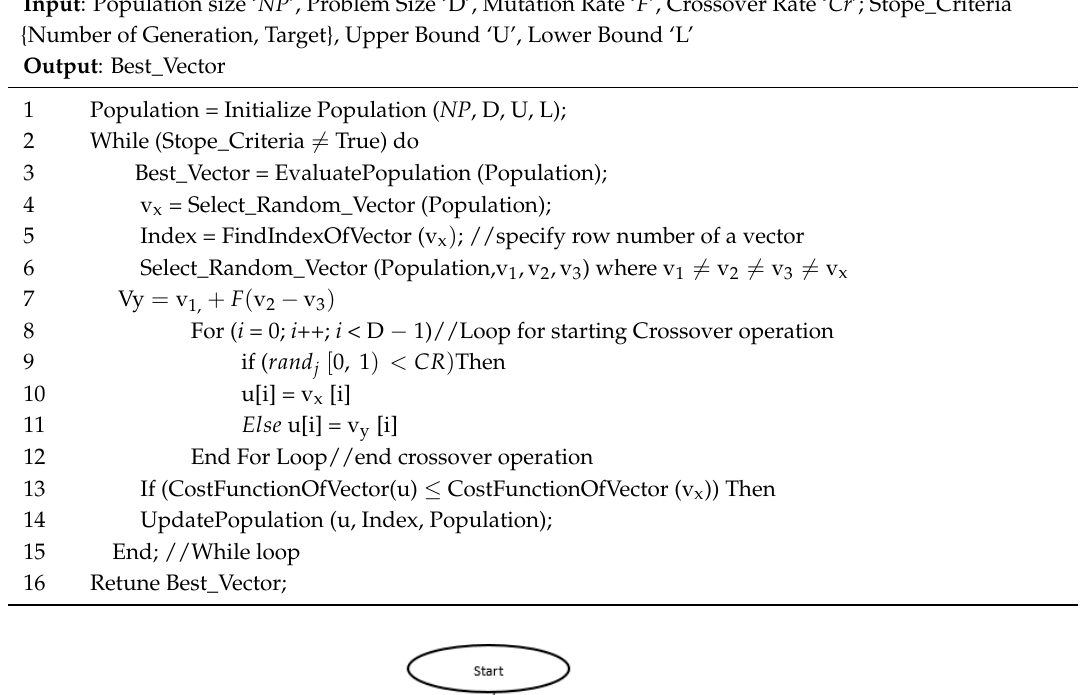
Algorithm 1. Pseudocode for classic Differential Evolution.